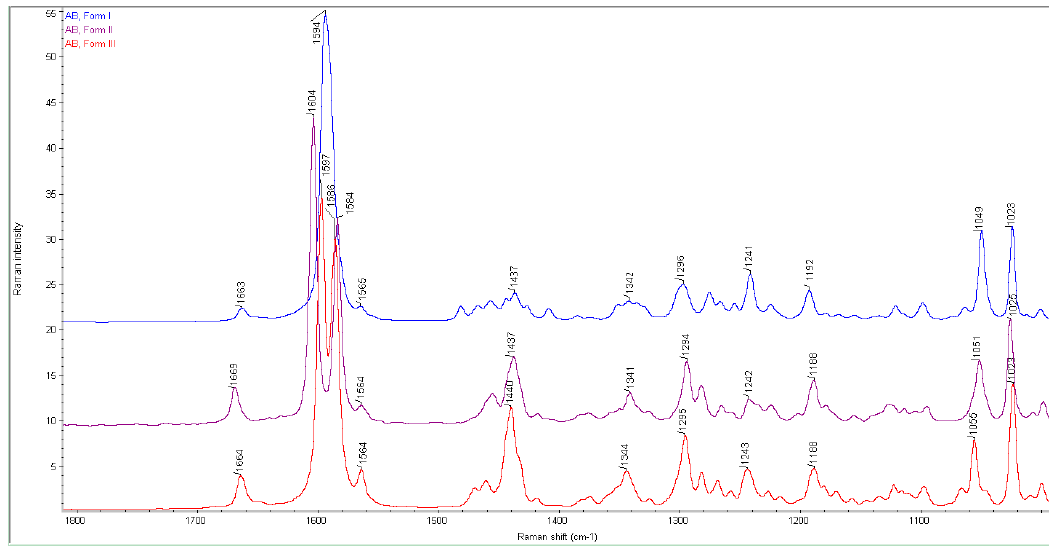
Figure 9. A comparison of the Raman spectra of three AB polymorphs. From the top to the bottom polymorphic spectra I, II, and III are shown.